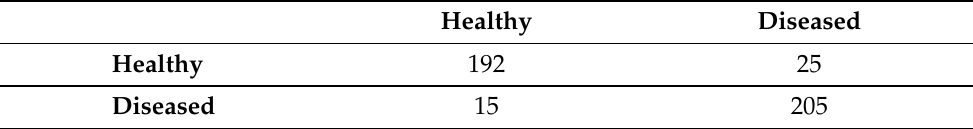
Table 5. Confusion matrix for the test data.